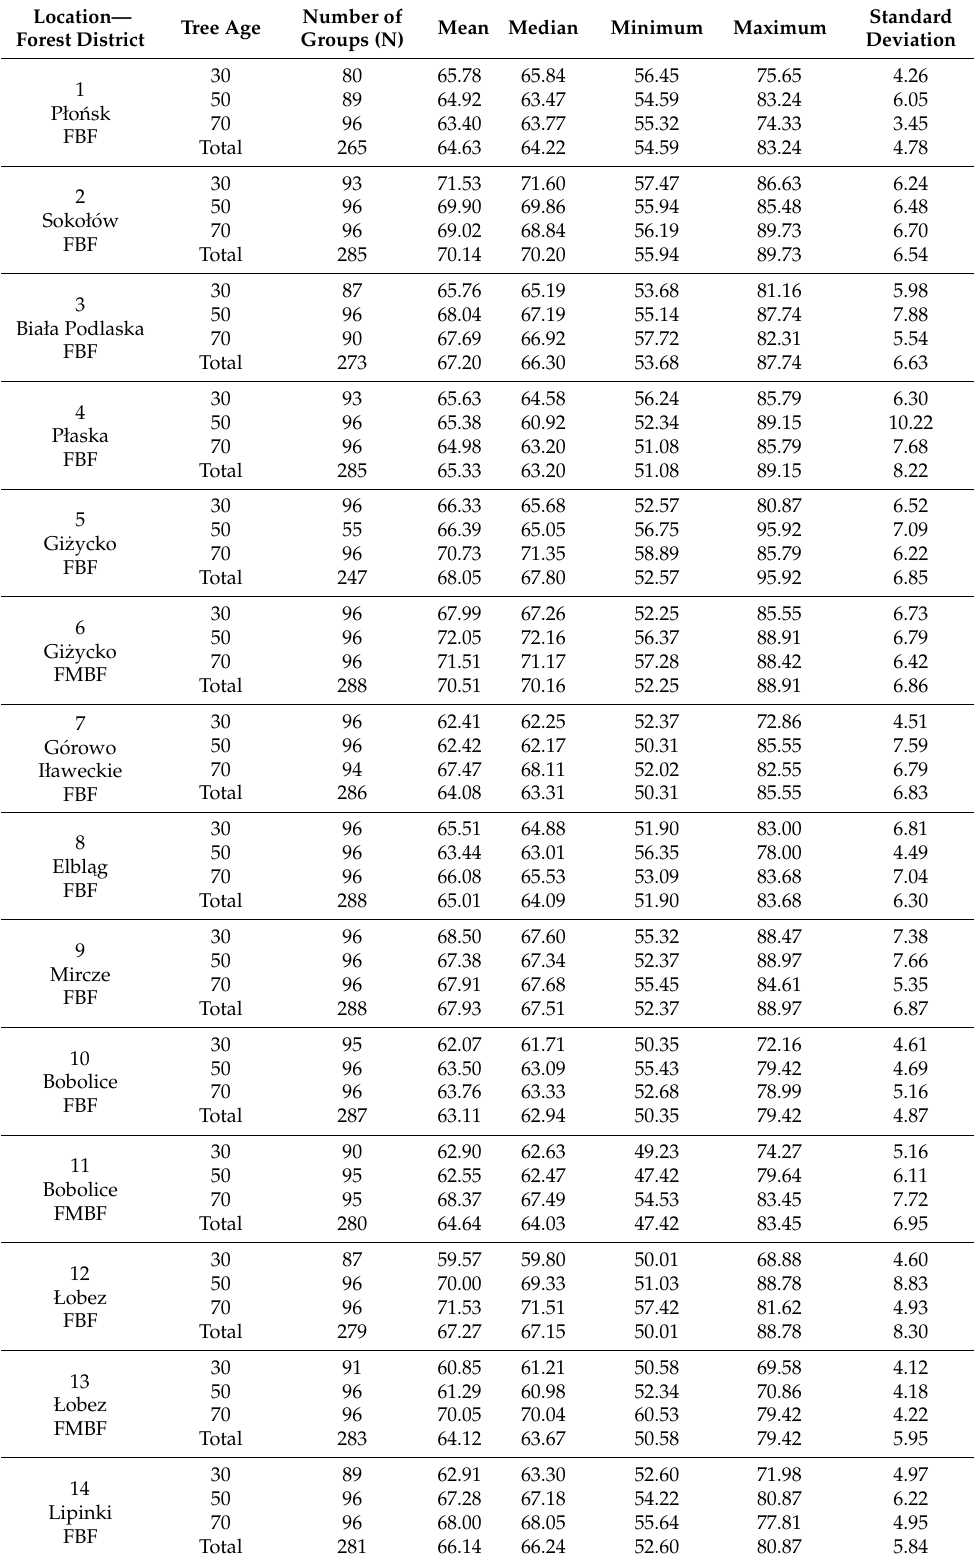
Table A1. Characteristics of Brinell hardness of silver birch wood on a transverse section